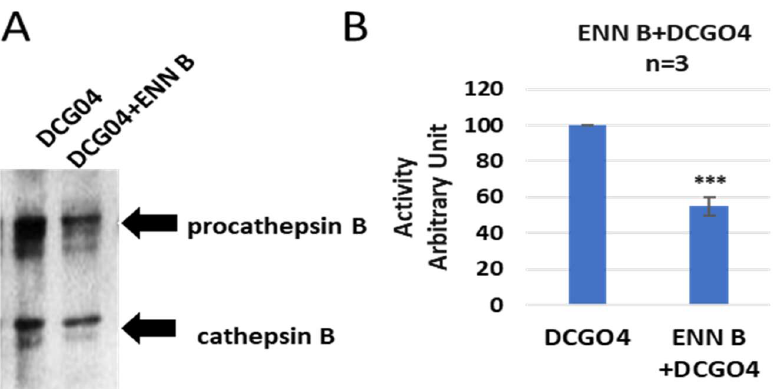
Figure 3. Avidin pull-down experiment of cysteine cathepsins before and after ENN B treatment. ( A ) Avidin pull-down experiment was performed as described in materials and methods. Conjugated proteins to avidin Sepharose beads were subjected to SDS-PAGE and Western blotting with antibodies specific to human cathepsin B. ( B ) Ratio of cellular contents of cathepsin B before and after treatment with ENN B. The data were analyzed by t -test and statistics using GraphPad Prism. *** p < 0.001. Graphs are shown as mean ± SE, N = 7.